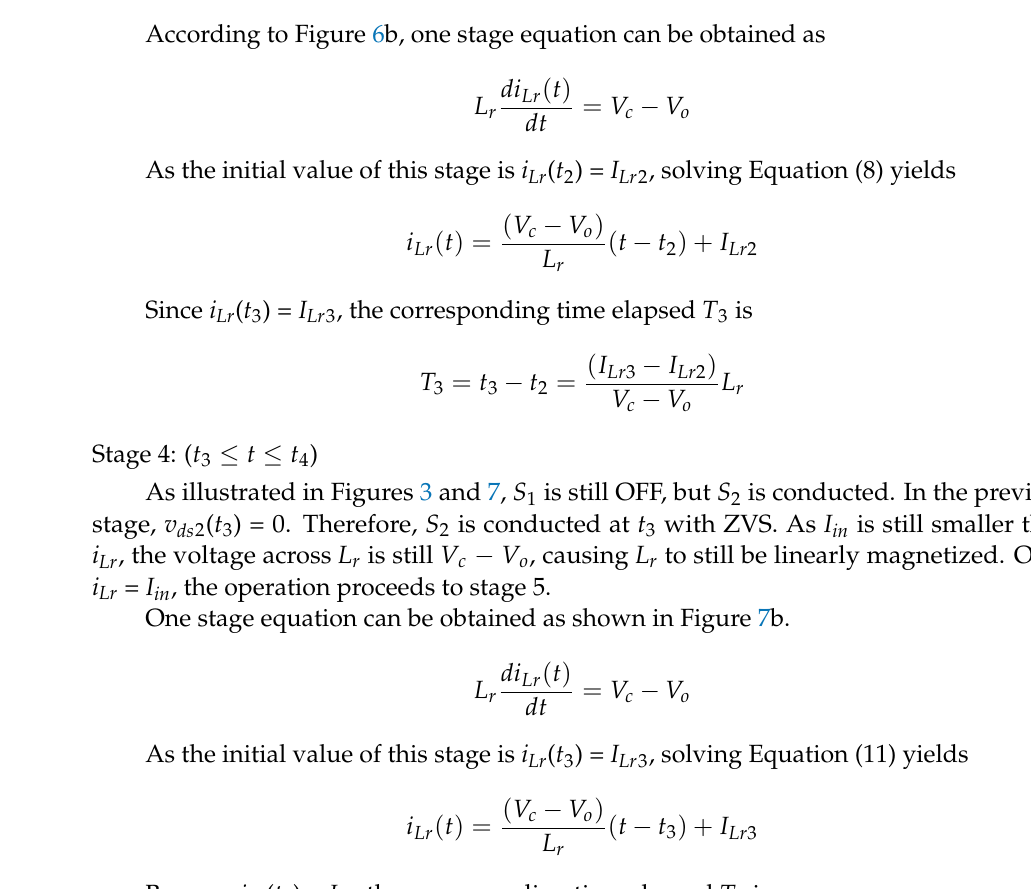
Figure 6. ( a ) Current path for stage 3; ( b ) equivalent of ( a